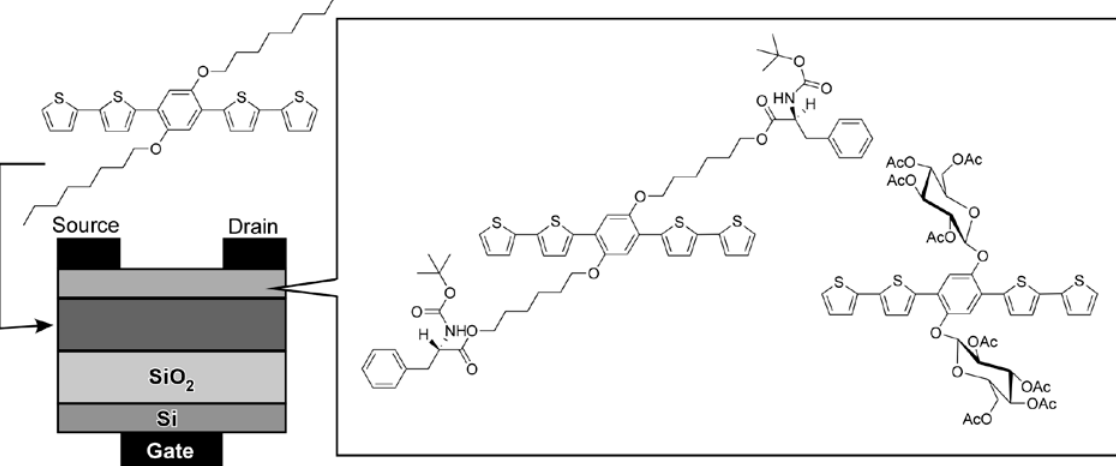
Figure 4. Layer-type FET sensor with alkoxythiophene oligomer with chiral recognition